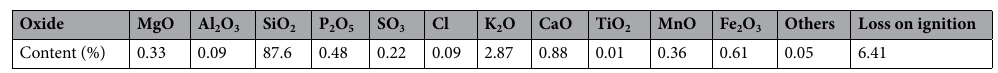
Table 2. RHA chemical composition.